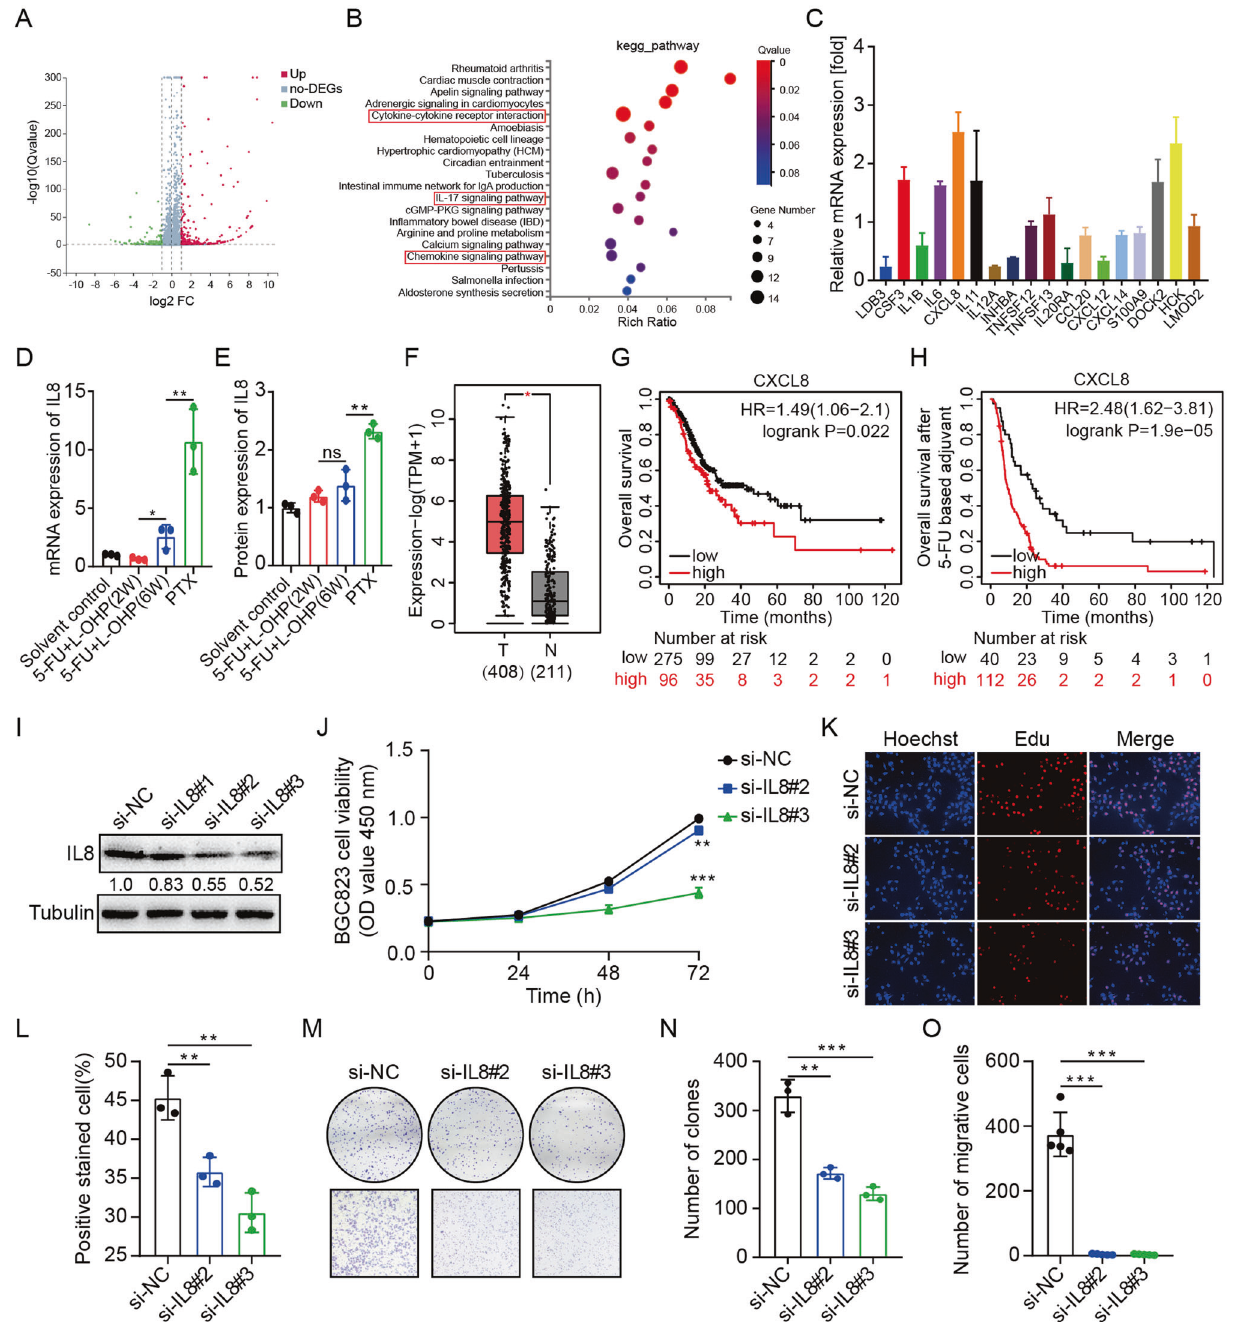
Fig. 3 Screening IL8 as the therapeutic target after chemotherapy resistance. A The volcano plot of RNA transcription sequencing of the fi rst-line chemotherapy group and the sequential chemotherapy group. A total of 256 differentially expressed genes (DEGs) with fold-change greater than 2. B KEGG pathways enriched by DEGs in the transcriptome affected by sequential chemotherapy compared with fi rst-line chemotherapy. C qRT-PCR assays were performed to detect the changes of the DEGs in the three enriched signaling pathways most associated with cancer in tumor tissues treated with sequential and fi rst-line chemotherapy. D , E IL8 expression at different periods of chemotherapy was detected by qRT-PCR assays and western blot analysis. Data are mean ± standard deviation. * P < 0.05, ** P < 0.01. F Upregulation of IL8 in GC samples was obtained in the GEPIA database. G Kaplan – Meier OS curves in GC patients according to the expression of IL8. H Kaplan – Meier OS curves in GC patients after 5-Fu therapy according to the expression of IL8. I Western blot analysis of IL8 expression in BGC823 cells transfected with siRNAs against IL8. J CCK8 assays was carried out to detect the viability of BGC823 cells transfected with si-IL8#2 and si-IL8#3. ** P < 0.01, *** P < 0.001. K , L Representative images ( K ) and quanti fi cation ( L ) of BGC823 cells transfected with si-IL8#2 and si-IL8#3 by EdU staining assays. Data are mean ± standard deviation. ** P < 0.01. M – O Representative images ( M ) and quanti fi cation ( N , O ) of BGC823 cells transfected with si-IL8#2 and si-IL8#3 by colony-forming experiments and transwell assays. Data are mean ± standard deviation. ** P < 0.01, *** P <